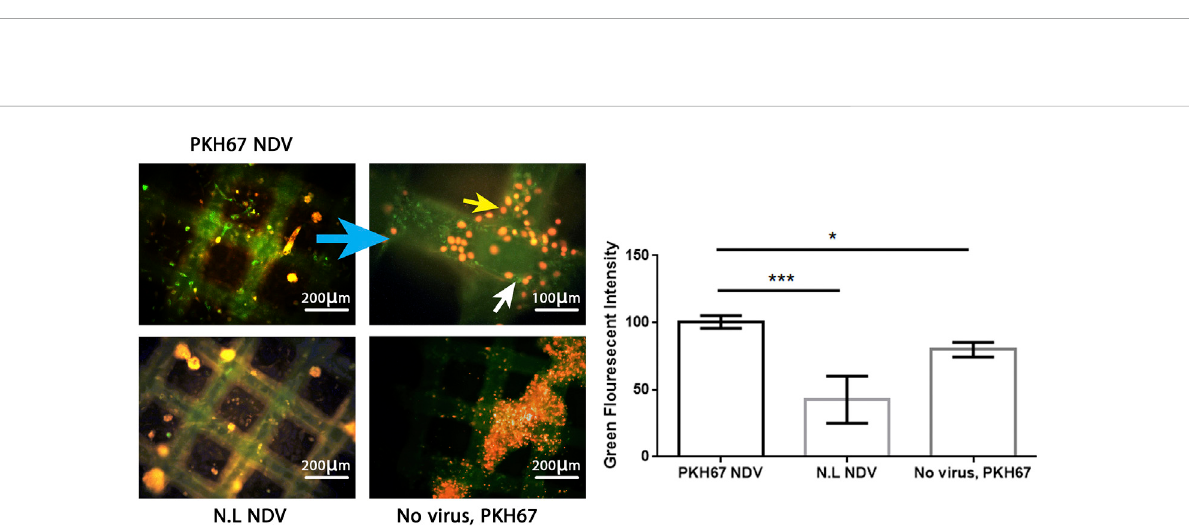
Infectivity analysis of PKH67-NDV in MCF7-hATMSCs 3D spheroids, coculture images of MCF7 with hATMSCs in the (3D) scaffold system; spheroids are infected atan MOI of 10 as seen under a fl uorescence microscope. Cells were infected with labeled NDV (virus carrying PKH67 linker). At 24 h post-infection, coculture spheroids cells were fi xed and stained with propidium iodide (PI) for nuclear staining. PI staining is shown in red/ orange,whilethecytoplasmisshowningreen fl uorescenceforinfectivityofthePKH67-NDVinsidecancercells ’ cytoplasm,whichcon fi rmsthe entry of labeled NDV. Also seen are few fl uorescent red-orange spheres with no green fl uorescence, which can be explained as a sphere of normal hATMSCsonlysparedbytheNDVasitisnotreplicatedinthenormalcells.Thetopleft fi gureshowsimagesofMCF7coculture×100,andthetopright fi gure isof ahigher magni fi cationof PKH67-NDV – infectedspheres, which appear destroyed, and shows thepresence ofcells with green cytoplasm (white arrow) and red-orange nuclei (yellow arrow) (×400). While the bottom left fi gure (non-labeled NDV) shows MCF7-hATMSCs coculture spherestreatedwithnon-labeledNDV,havinganucleusstainedred-orangewithpropidiumiodidedye.Thebottomright fi gurepresentscocultured spheroids of MCF7 spheroids cells, treated with PKH67 linker only without any virus (mock-infected), treated as the second control. The histogram clari fi estheintensityofPKH67 green fl uorescence,demonstratingthatPKH67-NDV – infectedsphereshavethehighestintensity whileshowinghigh infection of the labeled